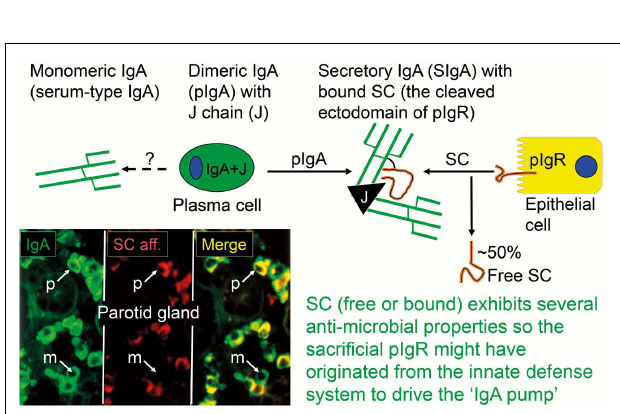
FIGURE 2 | Generation of secretory IgA (SIgA) and free secretory component (SC) . SIgA is formed as a hybrid antibody molecule stabilized by a disulfide bridge between the two cell products.The amount of dimeric IgA (pIgA) produced by a plasma cell depends on its level of J-chain expression, which generally is high in mucosal and glandular tissue. Inset (left) shows direct demonstration of abundant cytoplasmic expression of pIgA (p) in most plasmablasts and plasma cells in the parotid gland achieved by in vitro affinity test with free SC on tissue section as described (9), whereas a single cell producing only monomers (m) is seen in this field. On average, ∼ 50% of SC occurring in various secretions is in a free form (unoccupied by ligand).The immunostained panel is from Brandtzaeg